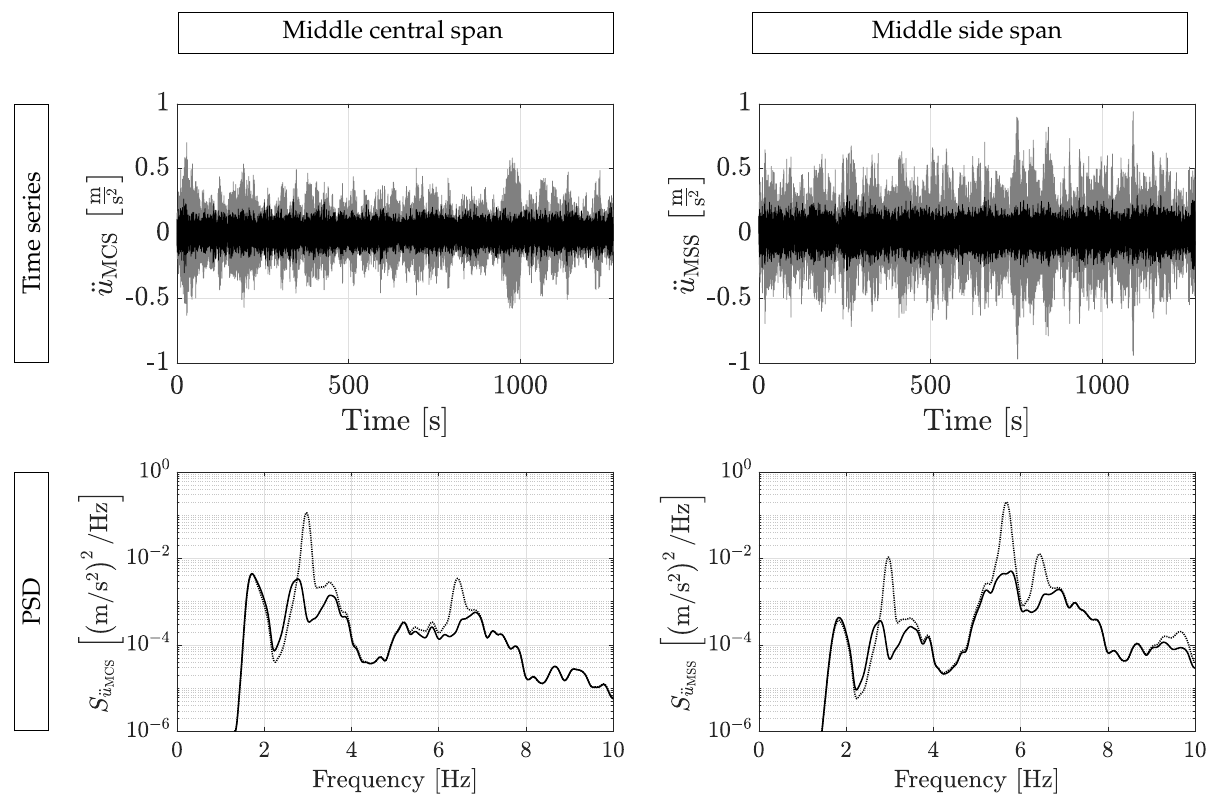
Figure 17. The vertical structural accelerations of the reference response with (black) and without mechanical HSI (gray) at the middle of the central span and the middle of the side span: time series and